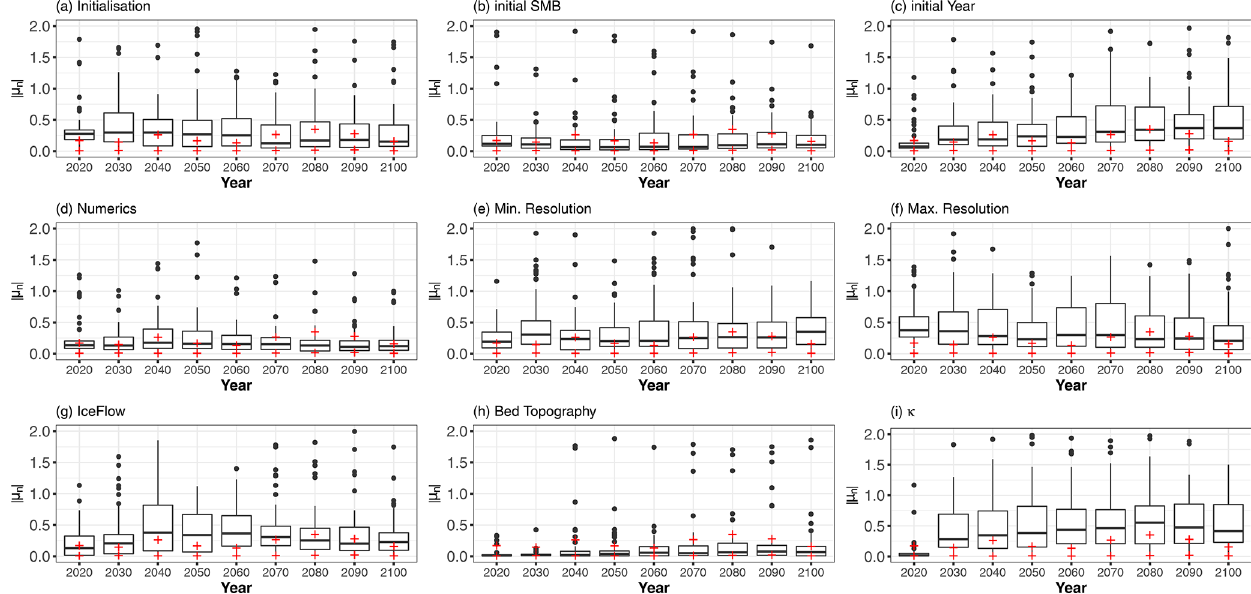
Figure 9. Statistics of | µ n | summarised by a boxplot at each time instant for all members of the MIROC5 RCP8.5-forced GrIS MME. The lower and upper red crosses are the first and third quartile respectively of the cross-validation error RAE n . If the boxplot does not overlap with the region defined by the interval between the red crosses, this indicates that the influence measured by | µ n | can be considered significant with respect to the ML prediction error. For readability, the upper bound of the y axis has been set to 2.